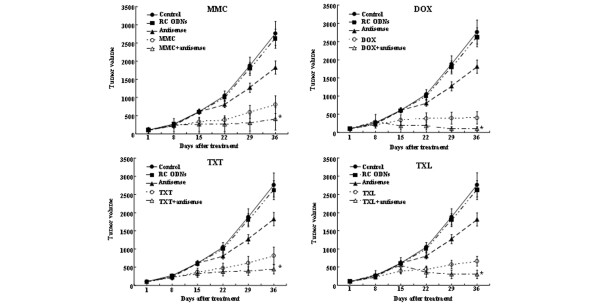
Effects of treatment with antisense Bcl-2 and mitomycin C, doxorubicin, paclitaxel, or docetaxel on ZR-75-1 cells. Enhancement of the antitumor effects of anticancer drugs by antisense Bcl-2 oligodeoxynucleotides in ZR-75-1 tumor xenografts. Each point represents the mean tumor volume of the eight mice in each group. Error bars indicate SD. *, P < 0.05, analysis of variance with Fisher's least significant difference test. The data presented are from two independent experiments. MMC, mitomycin C; DOX, doxorubicin; TXL, paclitaxel; TXT, docetaxel.